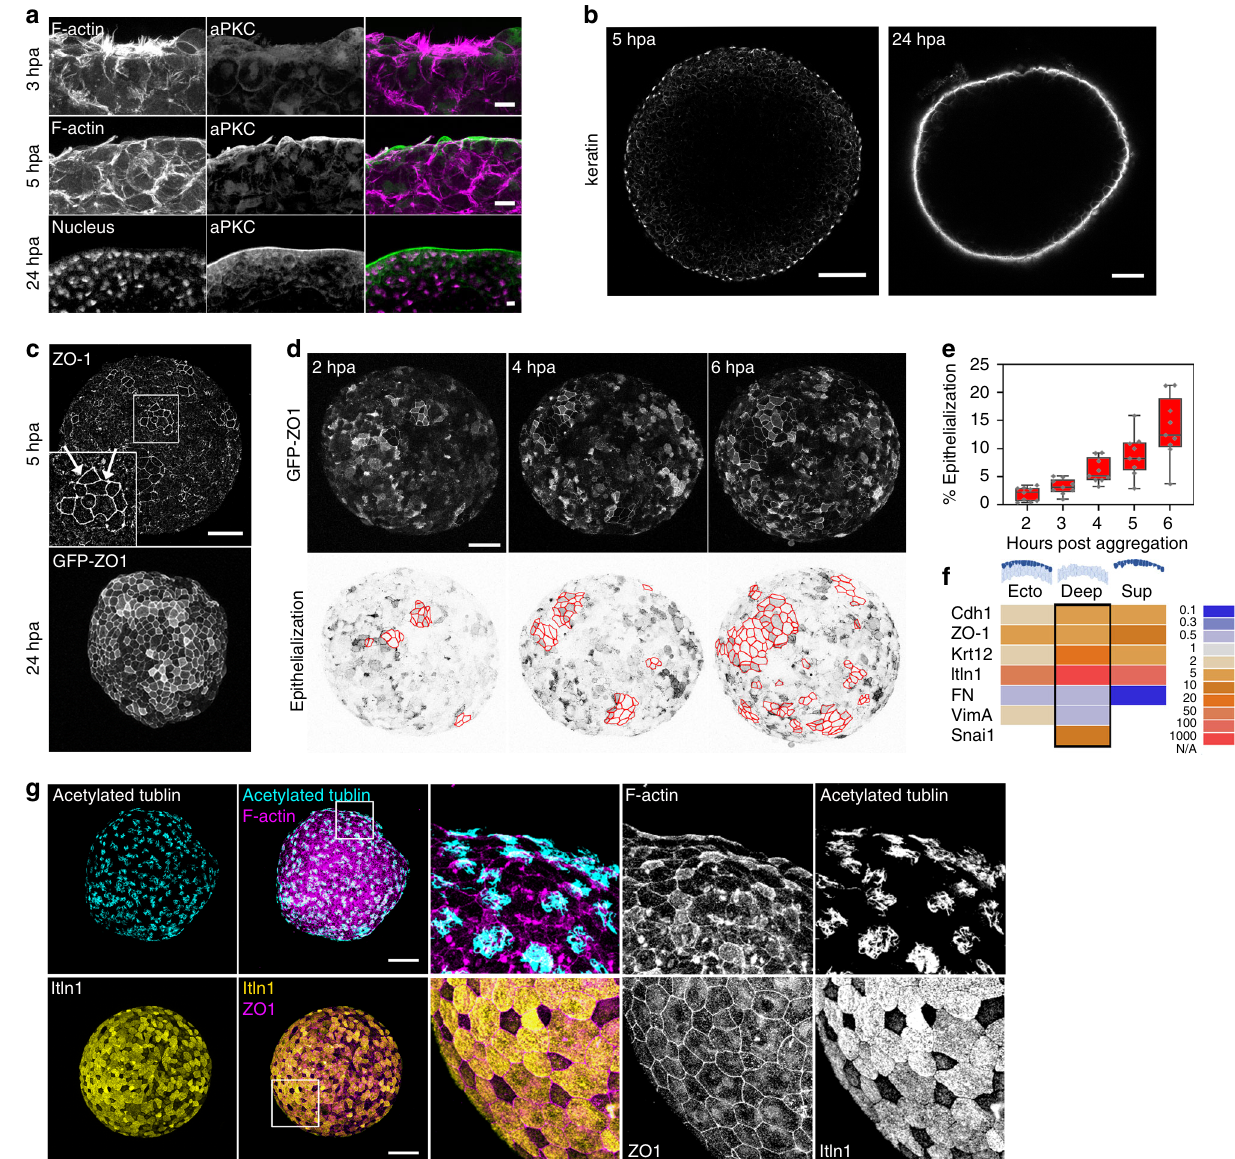
Fig. 2 Epithelialization precedes differentiation of mucus-secreting goblet cells. a Apical polarity protein aPKC localizes on the apical surface of aggregates by 5 hpa. Scale bar, 10 µ m. b Apical localization of epithelial cytoskeleton keratin is restricted to the outer surface of deep ectoderm aggregates. Cross sectional view of aggregates at 5 hpa (Scale bar, 100 µ m) and 24 hpa (Scale bar, 50 µ m). c Maximum intensity projection of epithelial tight junctional protein ZO-1 expression in aggregates at 5 hpa (top; immuno fl uorescence staining) and 24 hpa (bottom; GFP-ZO-1 expression). Epithelialized cells are marked by arrows (inset). Scale bar, 100 µ m. d Representative frames from a time-lapse sequence of an aggregate expressing GFP-ZO-1. Top panel: maximum intensity projection of GFP-ZO-1 shows cells undergo epithelialization (outlined with red on lookup-table-inverted images in lower panel) on the surface of aggregates from 2 to 6 hpa. Scale bar, 100 µ m. e Percentage of cells having undergone epithelialization increases over time (9 aggregates tracked from three clutches). Box plot shows minimum, fi rst quartile, median, third quartile, and maximum values. f qPCR expression pro fi ling in aggregates made of ectoderm, deep layer, or super fi cial layer cells. Expression of epithelial (Cdh1, ZO-1, Krt12, and Itln1) and mesenchymal (FN, VimA, and Snai1) genes are analyzed for CT-based fold changes from 3 hpa to 24 hpa. g At 24 hpa the deep ectoderm aggregate is covered by epithelial cells including differentiated mucus-secreting goblet cells (itln1) and radially intercalated multiciliated cells (acetylated tubulin). Scale bar, 100 μ